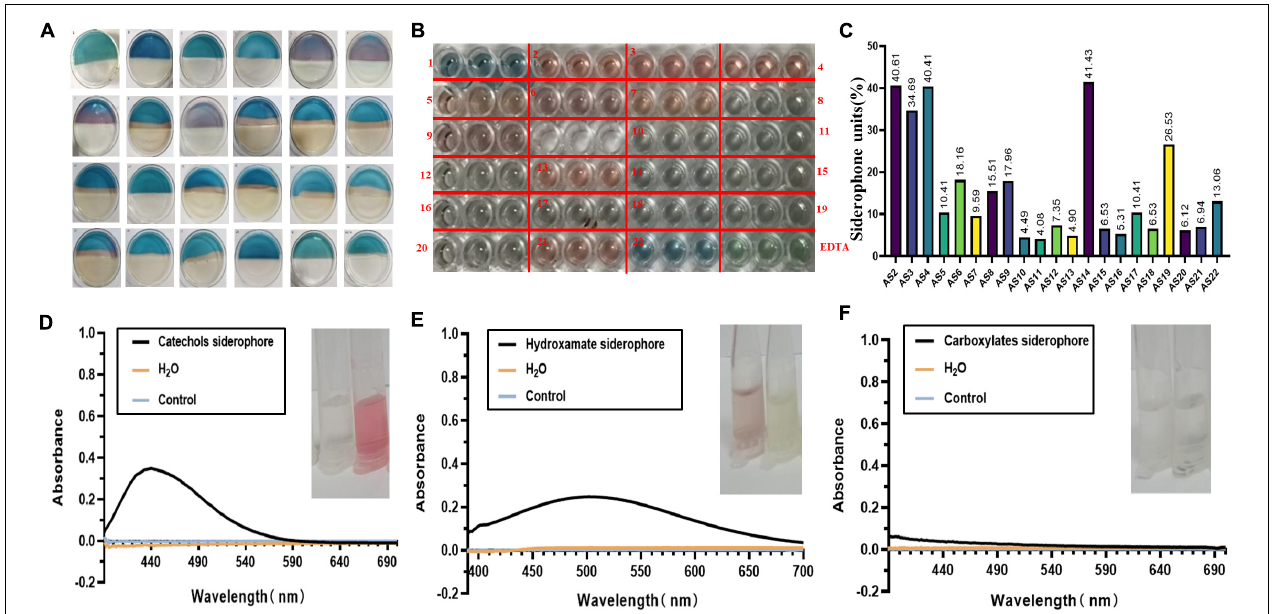
FIGURE 2 | The units and type of siderophores produced by 22 isolates. (A) SA-CAS agar plate assay. Isolates were cultured on SA-CAS agar plates, and the blue color changed to pink or yellow. (B) CAS liquid testing was performed in a 96-well plate. (C) The units of siderophores produced by 21 isolates calculated according to SU = (Ar − As)/Ar ∗ 100%. The absorbance was measured at 630 nm. (D) Catecholate-type siderophore. AS2, AS3, AS4, AS5, AS6, AS7, AS9, AS14, and AS22 absorption peaks were detected at 440 nm. (E) Hydroxamate-type siderophore. The absorption peaks of AS8, AS10, AS11, AS12, AS13, AS15, AS16, AS17, AS18, AS19, AS20, and AS21 were detected at 505 nm. (F) Carboxylate-type siderophore. No absorption peak was detected in any of the samples at 190–280